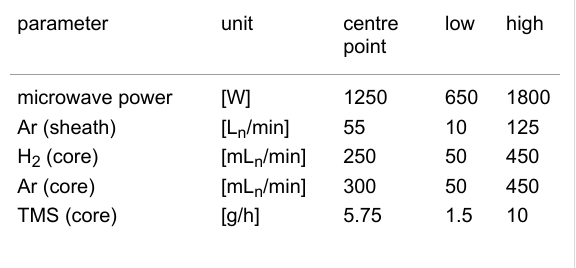
Table 1: Summary of the experimental set points for the experimental design (design of experiment,